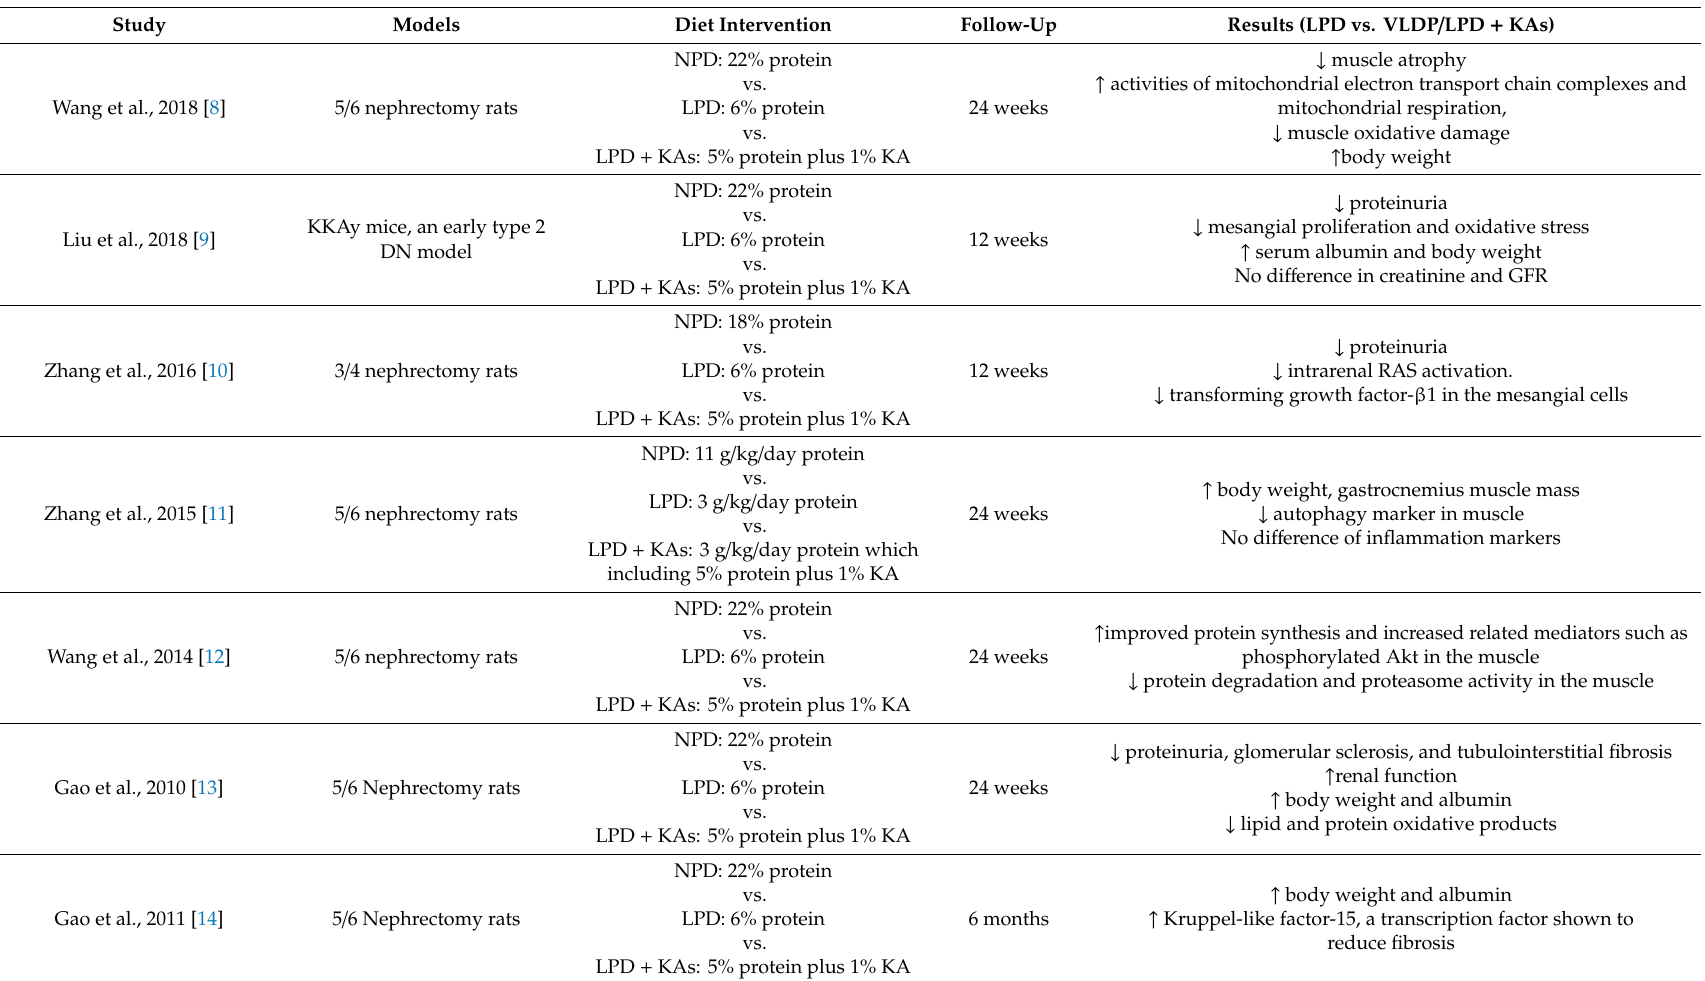
Table 2. Animal studies that examined the e ff ects of VLPD / LPD supplemented with ketoacid analogues on various